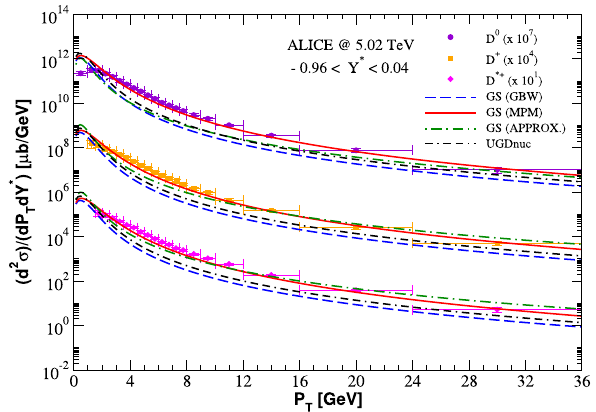
Fig. 4 Thedifferential D 0 , D + ,and D ∗+ productioncrosssectionsasa √ s = 5 . 02 TeV considering function of P T and Y in pPb collisions at − 0 . 96 < Y ∗ < 0 . 04. The predictions given by the GS (GBW) , GS (MPM) , GS(APPROX.) , and UGDnuc models are directly compared to the experimental data from the ALICE Collaboration [73] − 5 < Y ∗ < − 4 . 5. It should be noticed that the results with the UGDnuc , where the parameter B < 3, are reliable [see Eq. (15)] due to the fast series